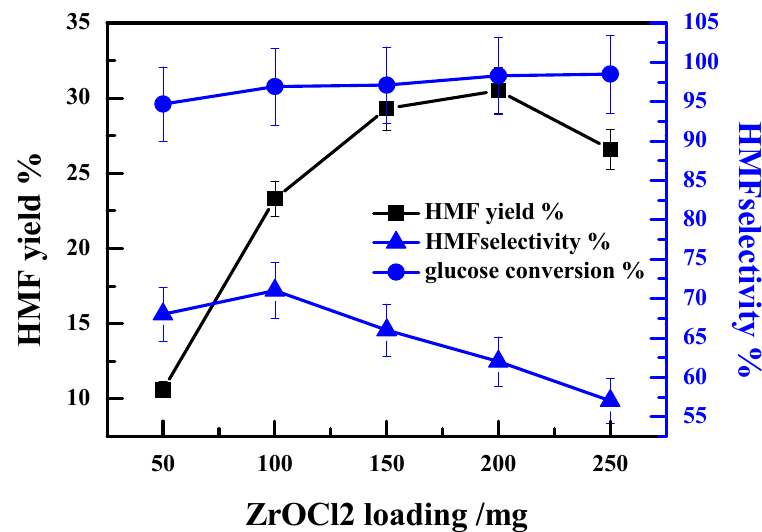
Figure 2. Influence of ZrOCl 2 loading on glucose conversion.Reaction conditions: 0.05 g [HO 2 CMMIm]Cl, 0.1 g glucose, 3.0 g isopropanol, 3 h reaction time, 150 °C reaction temperature.